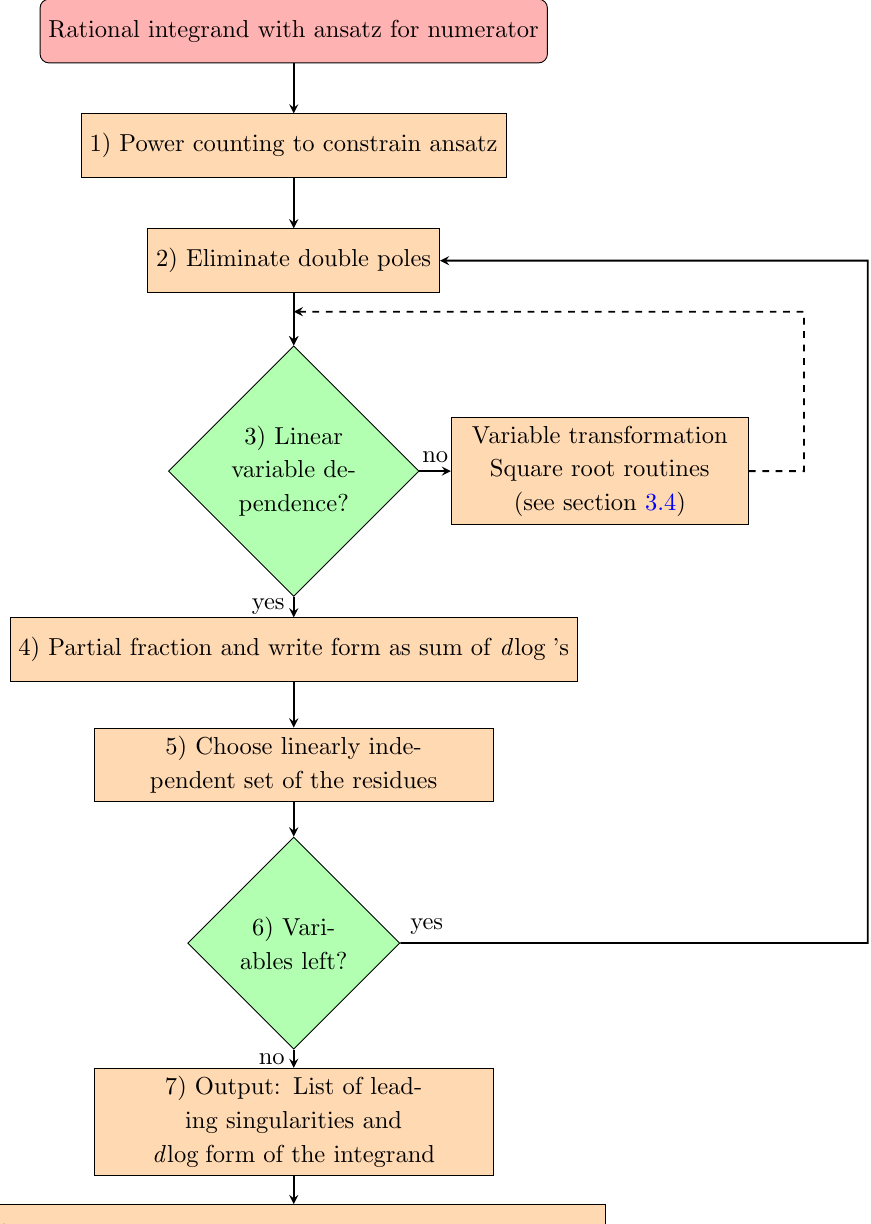
Figure 3 . Work(cid:13)ow of the d log algorithm.